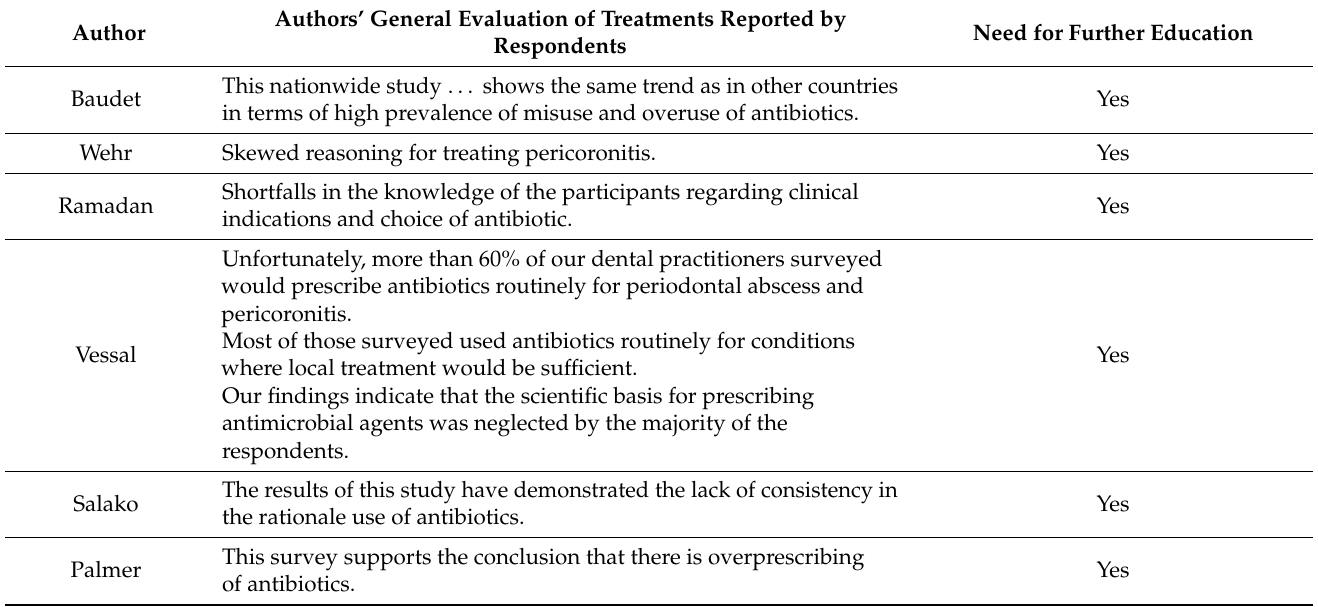
Table 9. Authors’ general evaluation of treatments reported by respondents of their studies and authors’ opinion on the need for further education in appropriate